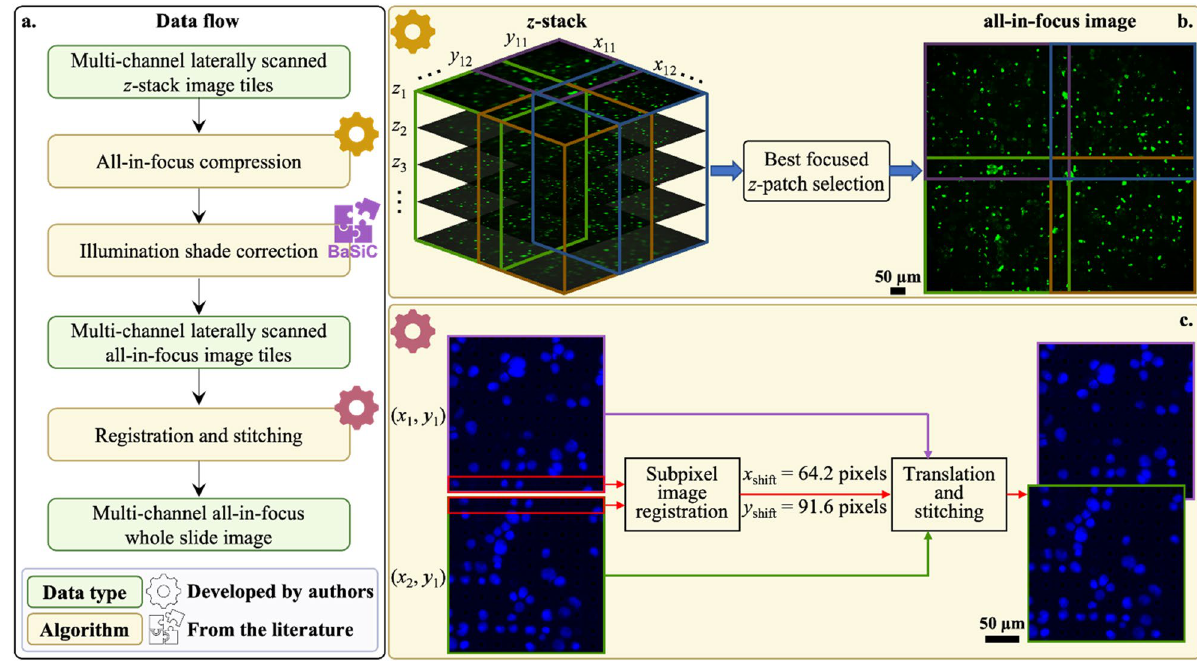
Figure 3. Data preprocessing pipeline. ( a ) Data flow starting from raw measurement and ending with a multi-channel all-in-focus whole slide image. Preprocessing consists of three algorithms, among which two are developed by authors and the other one is adapted from an existing work. ( b ) Principle of all-in-focus compression. Z -stack at each x – y location is split into smaller patches and the best focused z -patch is selected with focus measure. Finally, z -patches are fused into an all-in-focus x – y tile. c Principle of registration and stitching. There is overlap between adjacent x – y tiles due to the tilt between scanner lateral movement coordinates and camera frame coordinates. Subpixel image registration algorithm relies on the overlapping region to find the subpixel shift between two adjacent x – y tiles. Taking the upper left corner tile ( x 1 , y 1 ) as the anchor for the final mosaic, all other x – y tiles are translated and stitched to it by blending based on distance